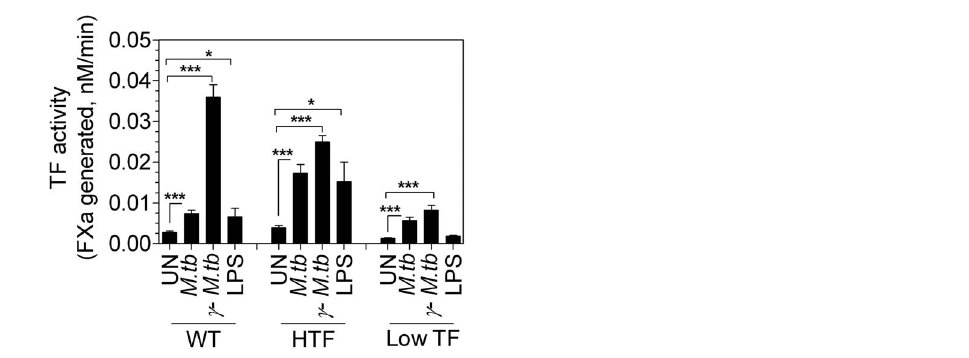
Figure 6. Ex-vivo M.tb stimulation increases procoagulant activity of macrophages of wild-type (WT), HTF and low TF. Bone-marrow-derived macrophages ( , 0.5 6 10 5 cells) were either stimulated with live M.tb (10 CFU/cell) or 10 m g/ml of gamma-irradiated M.tb ( c -M.tb ) for overnight in antibiotic free RPMI complete medium. Macrophages were also stimulated with LPS (1 m g/ml) as a positive control for 6 h. At the end of the treatment, TF activity was measured in FX activation assay. * denotes significantly different from unstimulated controls. (* p , 0.05; ** p # 0.001; *** p , 0.0001) as obtained by Students t-test. Data are mean ¡ SEM (n 5 6– 17).